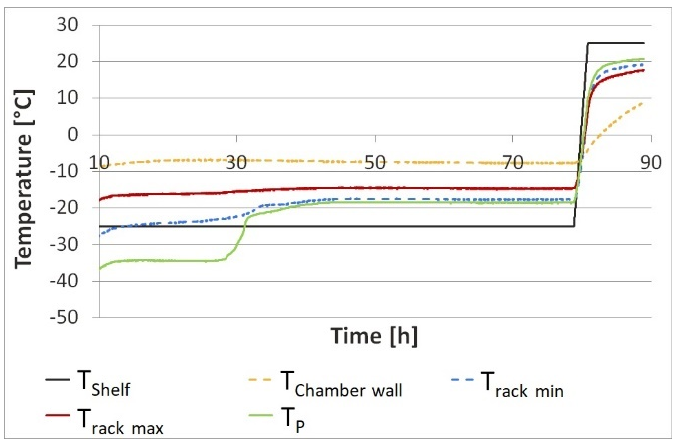
Figure 3. Temperature mapping: cold and hot spots of the rack in comparison to T P and T chamber wall . Table 2. Temperatures of rack, product, and chamber wall during primary drying.